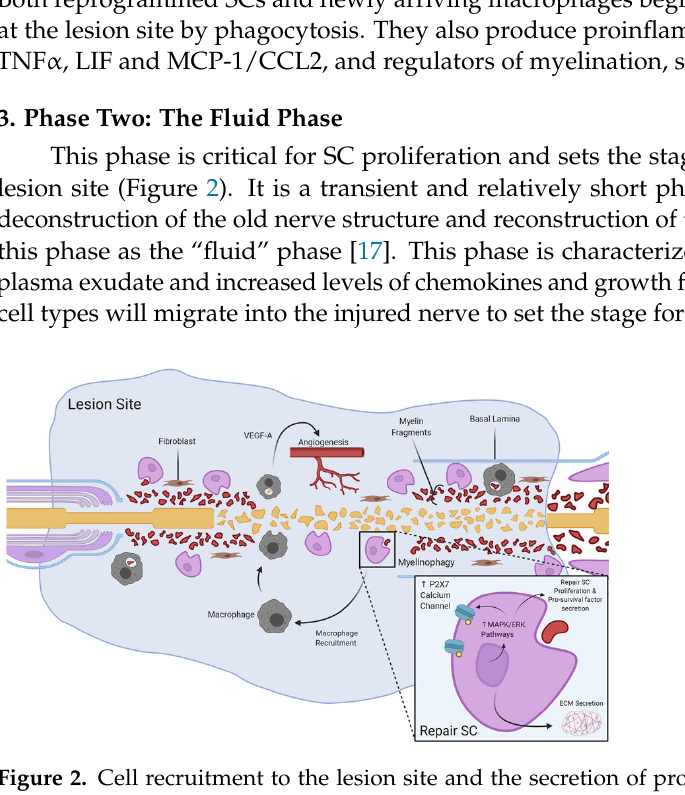
Figure 2. Cell recruitment to the lesion site and the secretion of pro-survival factors, angiogenic factors and fibrils. The figure was adapted from “Peripheral Nervous system (PNS) Myelin Structure” by BioRender.com (accessed on 2020). SC, Schwann cell; ECM, extracellular matrix; VEGF-A, vascular endothelial growth